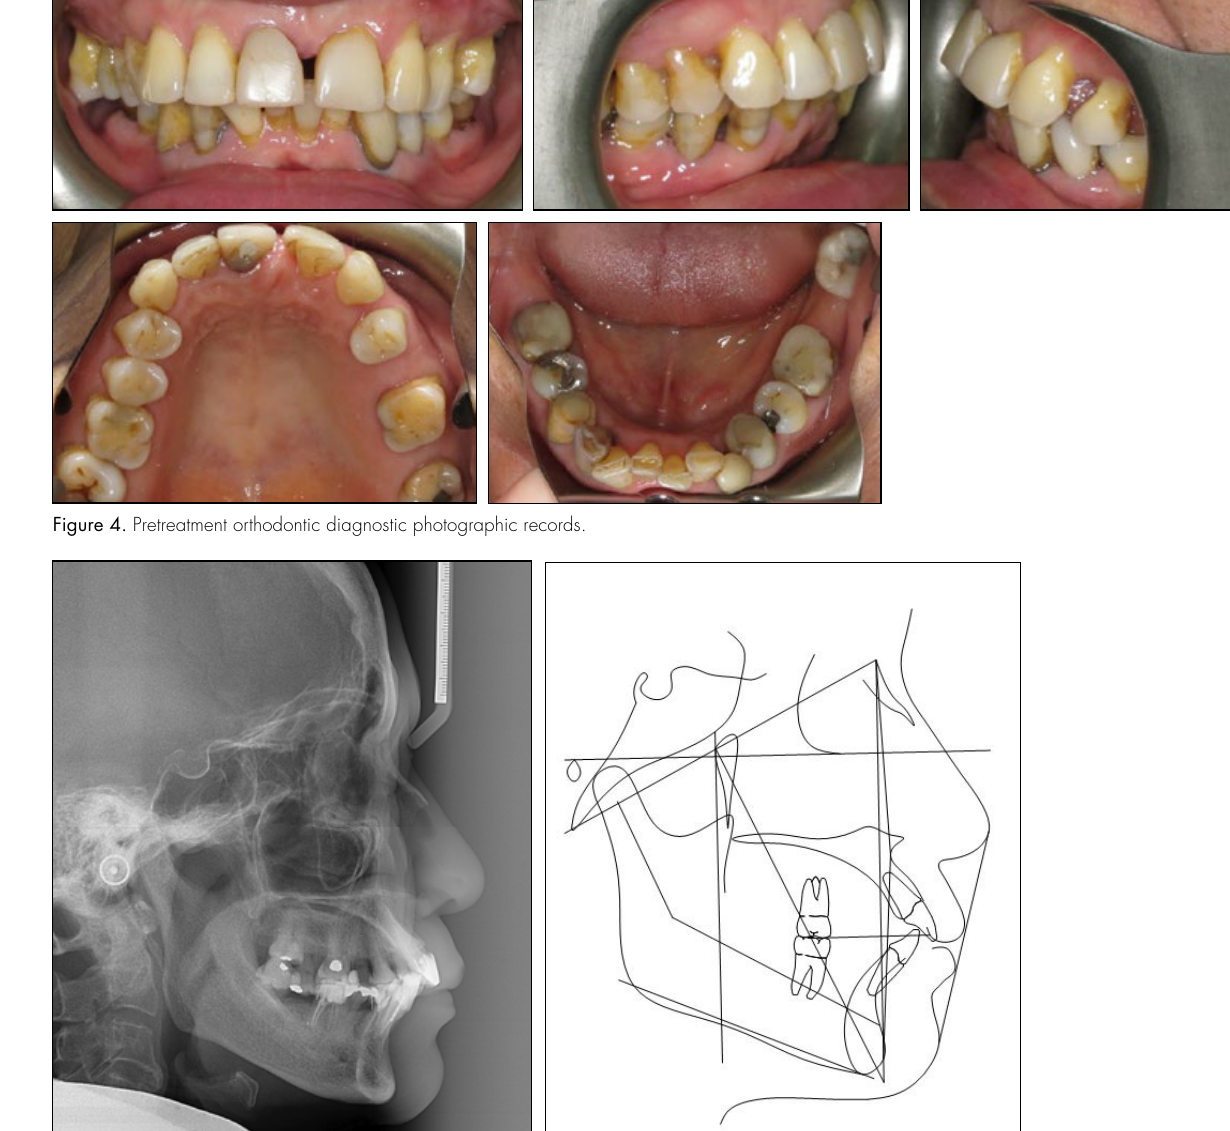
Figure 5. Pretreatment cephalogram and cephalometric